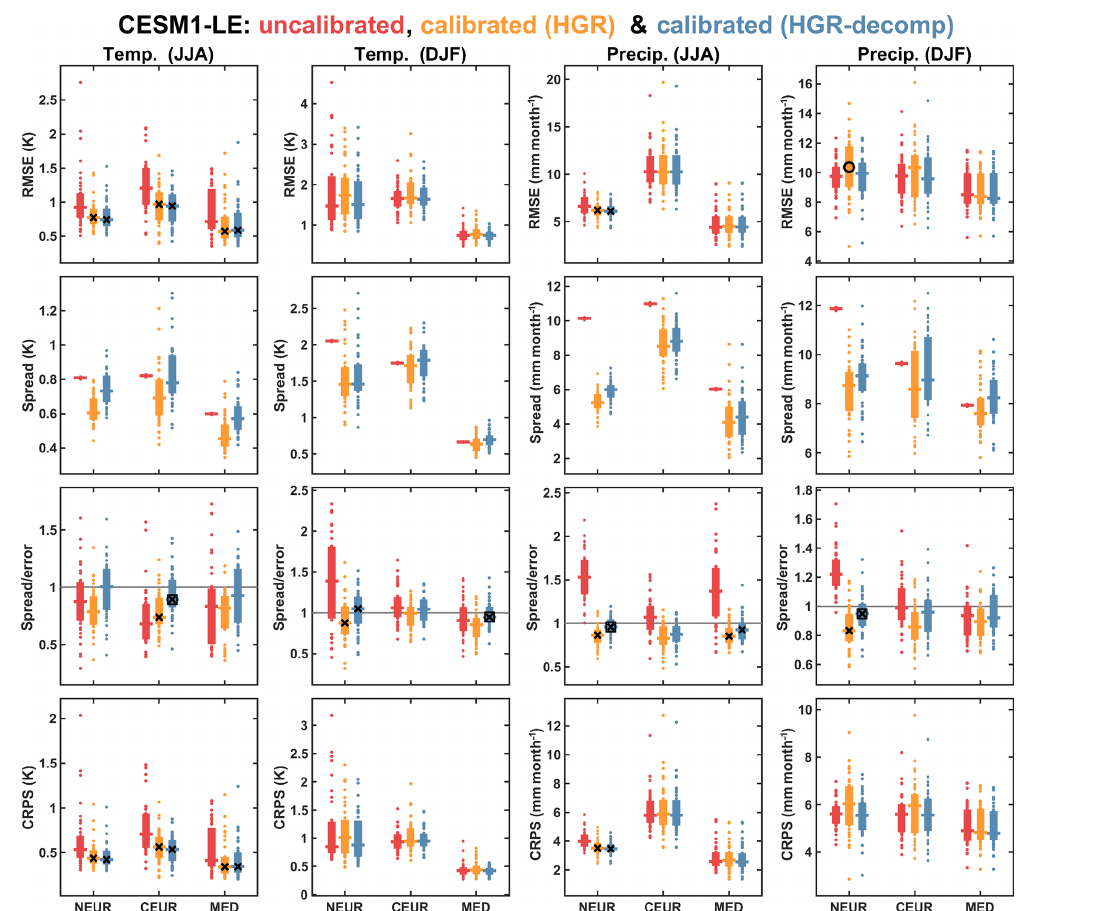
Figure 5. Overview of verification of the HGR and HGR-decomp calibration methods compared with the uncalibrated CESM1-LE data in the European regions. Results are shown for all of the verification measures, for both summer and winter seasons and for temperature and precipitation. The verification statistics for each of the individual CMIP5 models are shown in dots, the interquartile range of this distribution is shown by the solid bars and the median is indicated by the horizontal lines. For the calibrated RMSE, spread / error ratio and CRPS values, the black crosses indicate where the calibration represents a significant improvement over the uncalibrated (but bias-corrected) ensemble at the 90% significance level. Black circles indicate where the calibration is significantly worse than the uncalibrated ensemble (at the 90% level). Black boxes indicate where the HGR-decomp method of calibration is significantly better than the HGR method (at the 90% level). The significance levels were calculated using the non-parametric Mann–Whitney U test, applied to the distributions of the verification scores from the 39 CMIP5